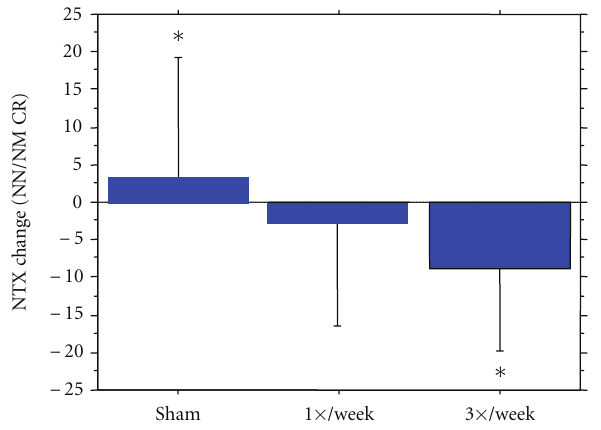
Figure 2: Group e ff ect: Absolute changes in NTx/Cr (nm/mmCr) values presented as Mean ± SD. Analysis by ANCOVA model with changes score as dependent variable and group assignment,baseline value of Ntx/Cr, age, height, use of HRT, and years since menopause as independent variables. Group e ff ect for model was P < . 05, post-hoc pair-wise comparisons analyzed by post-hoc LSD t -tests. ∗ Indicates significance ( P < . 018) between the Sham and 3 × /week